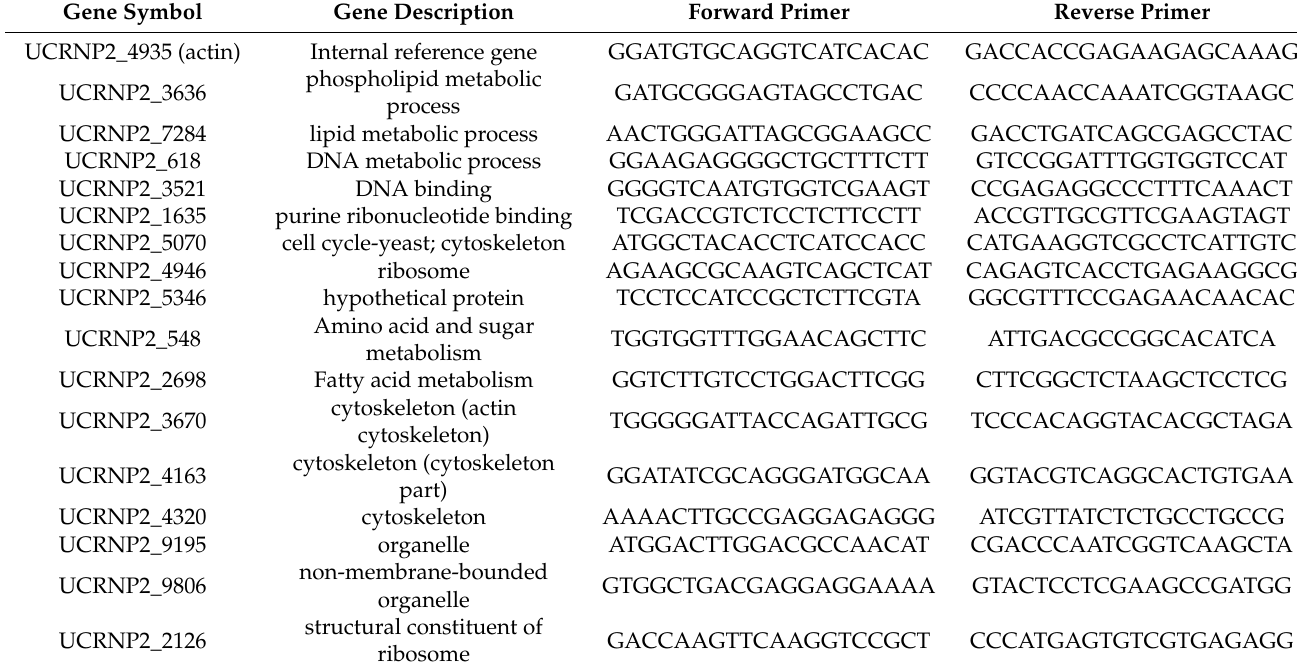
Table A1. Primers used for qRT-PCR.